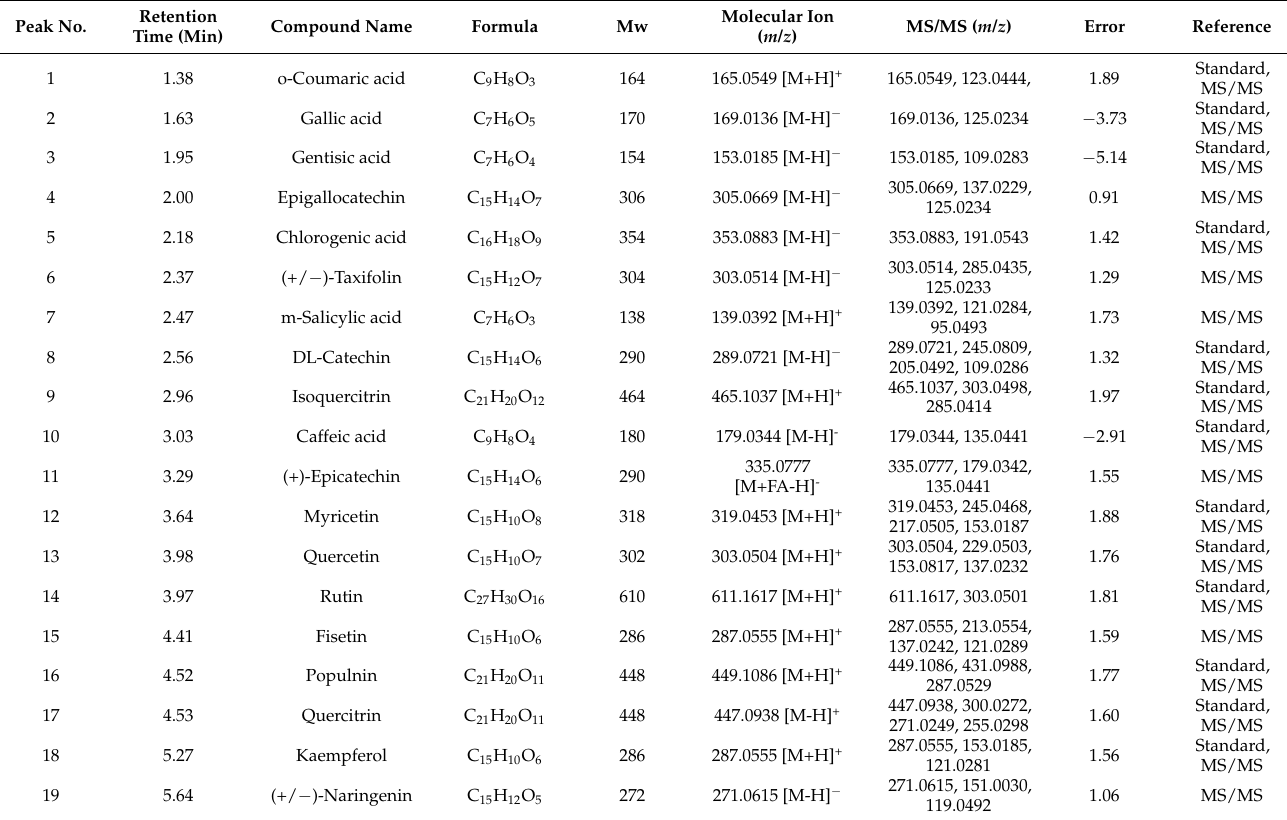
Table 2. Identification of the main phenolic compounds in peel and pulp of the four wampee samples from South China by UHPLC-Q Exactive